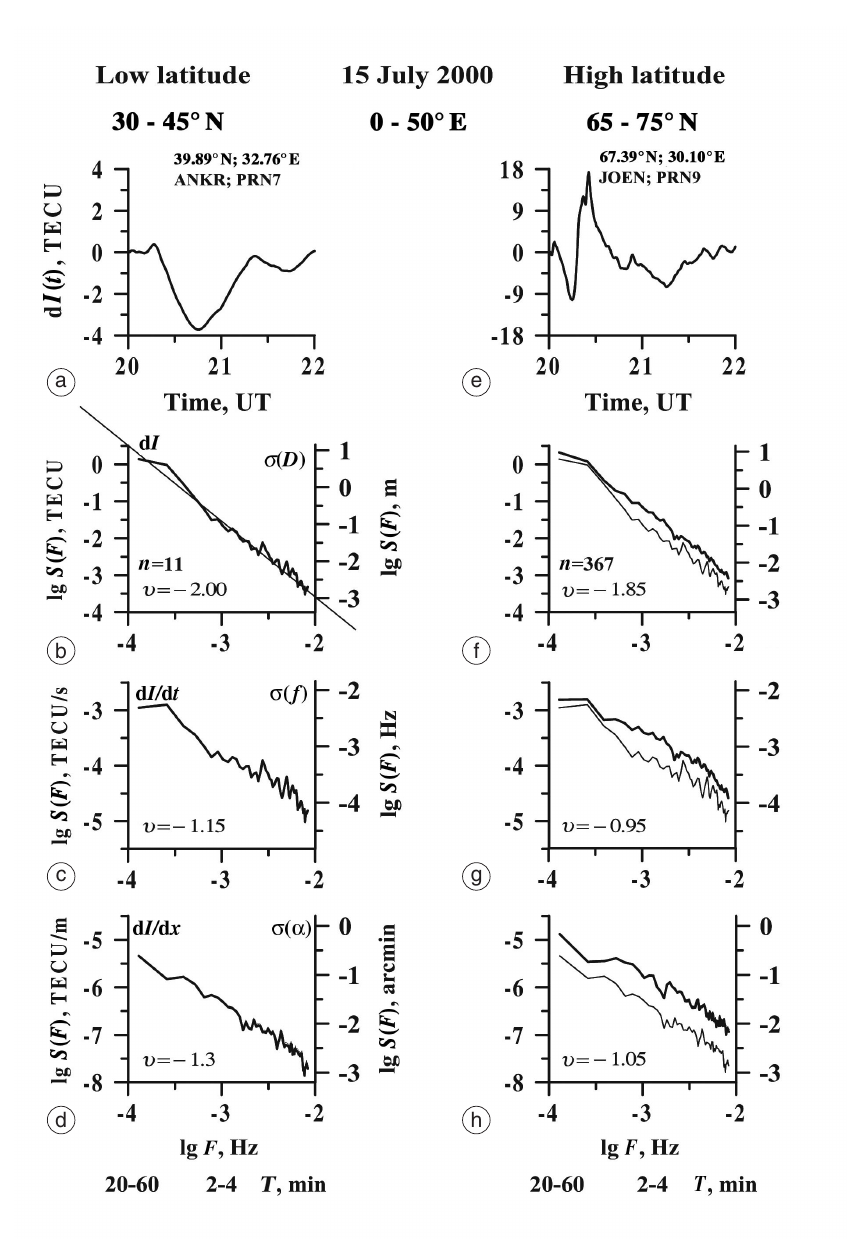
Fig. 7a-h. TEC variations dI ( t ), logarithmic scale amplitude spectra S ( F ) of TEC fluctuations and derivatives (left scale in the panels b-d) and f-h)), and the fluctuation spectra of σ ( D ), σ ( f ) and σ ( α ) converted to the working fre- quency of 300 MHz (right scale in the panels b-d and f-h) for the lower latitudes (30-45°, on the left panels) and a higher latitudes (60-75°, on the right panels) in Western Europe during major magnetic storm July 15,